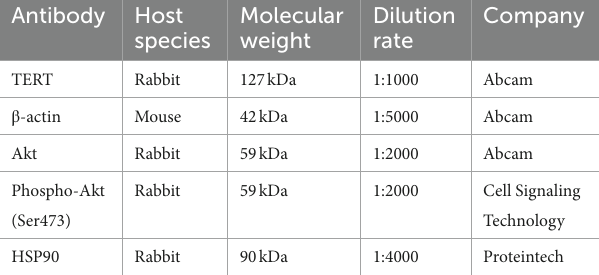
TABLE 2 Information for primary antibodies used in the present